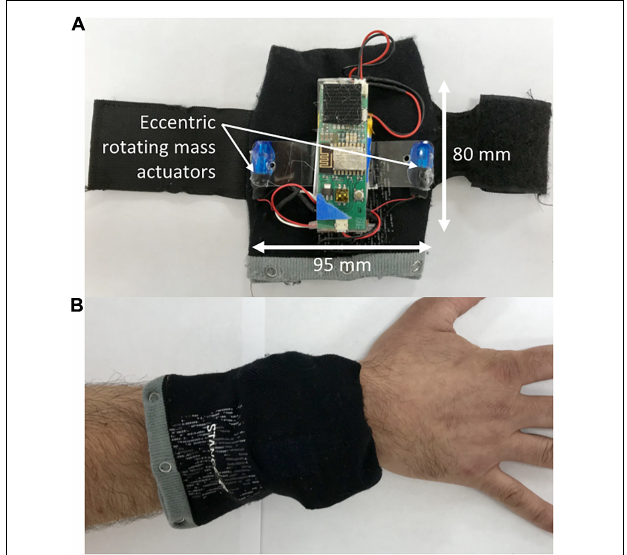
FIGURE 1 | The wearable vibrotactile stimulation device. Each vibration unit powered two eccentric rotating mass actuators from which the vibrotactile stimulation was delivered (A) . The vibration units were housed in cloth pouches that were attached to the subject’s wrists and ankles using a Velcro strap (B) .